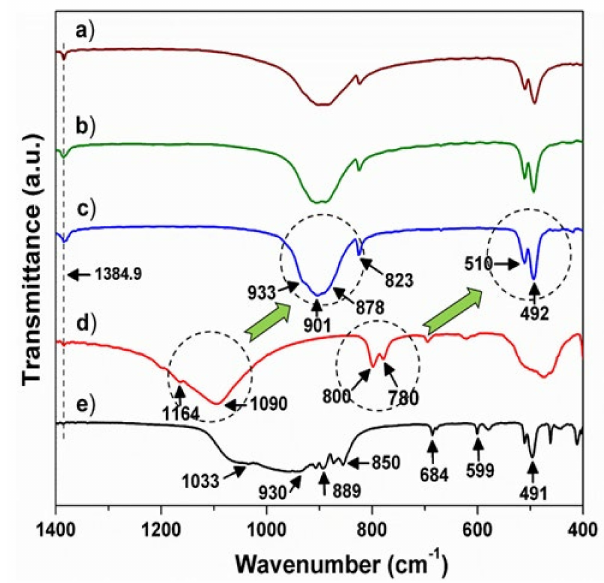
Figure 4. Infrared (IR) spectra of BSON:Eu 2 + phosphor synthesized using α -Si 3 N 4 –100% ( a ), SiO 2 –50% and α -Si 3 N 4 –50% ( b ), SiO 2 –100% ( c ), SiO 2 (after firing at 1250 °C under 4%–H 2 / Ar) ( d ), and α -Si 3 N 4 ( e